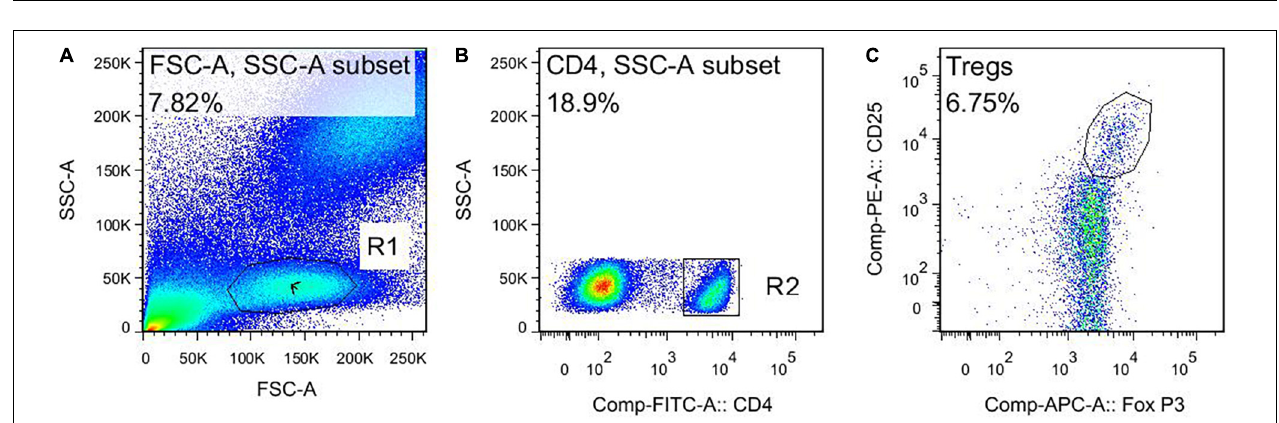
FIGURE 2 | The flow cytometry gating strategy for TBNK. (A) Lymphocytes. (B) T lymphocytes (CD3 + T cells). (C) The proportion of CD4 + T cells (CD3 + CD4 + T cells). (D) The proportion of CD8 + T cells (CD3 + CD8 + T cells). (E) The B cells (CD3–CD19 + B cells). (F) The NK cells (CD3–CD16 + CD56 + NK cells).